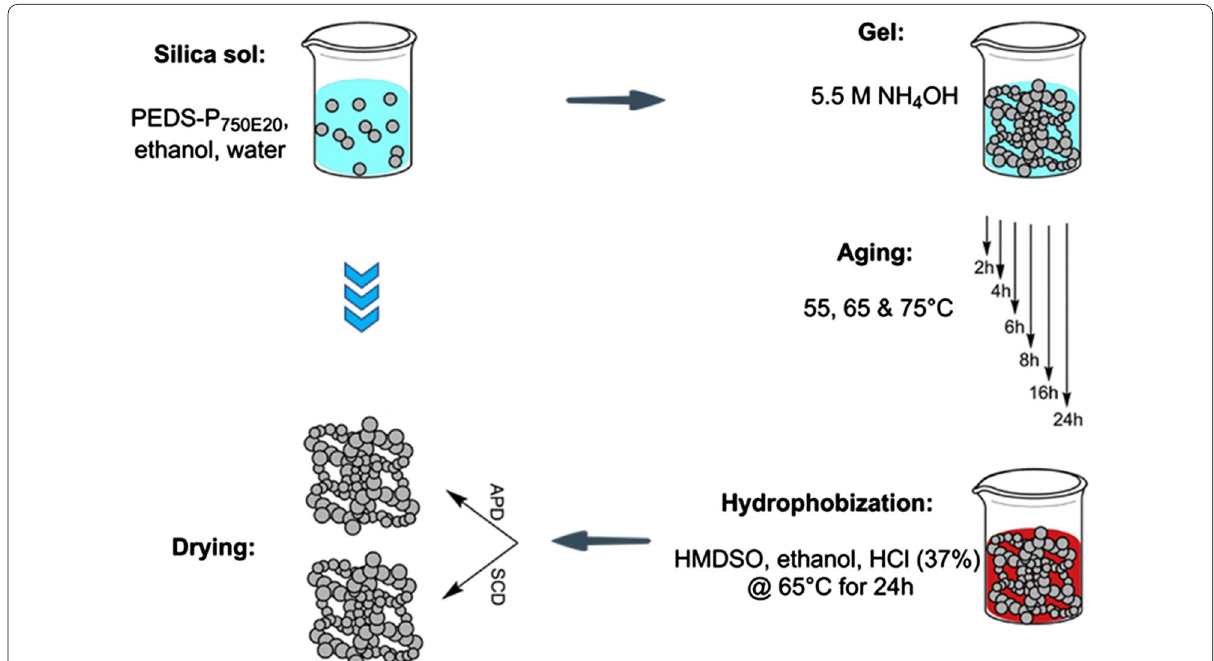
Fig. 2 Schematic process for the synthesis of silica aerogel [41] Copyright 2017 Microporous and Mesoporous